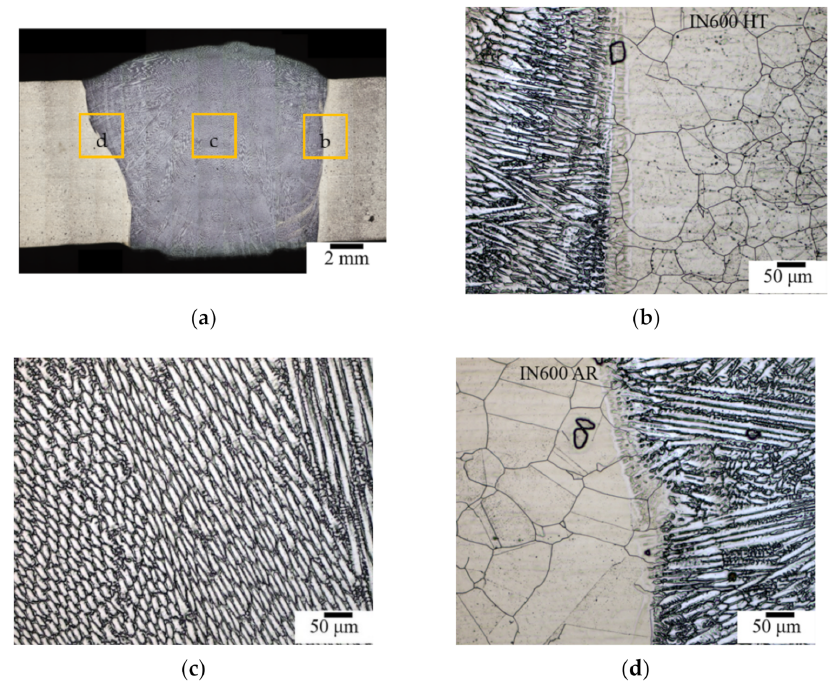
Figure 4. ( a ) Macrograph of the welded joint obtained with the ER310 filler and ( b – d ) microstructural details as observed in the